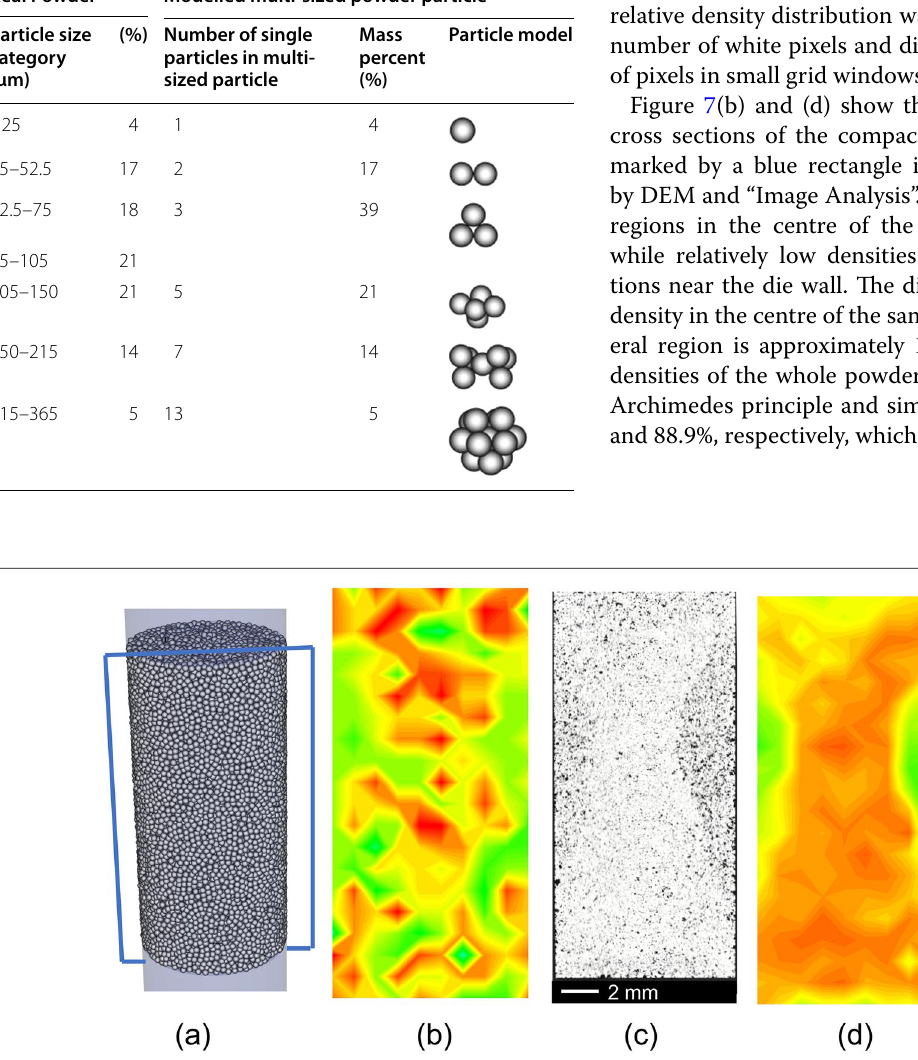
Figure 7 a Position of the selected cross section of compacted samples in simulation model, b density distribution in the cross section after compaction simulation, c Microstructure of the cross section of the compacted sample recorded by light microscopy, d after “image